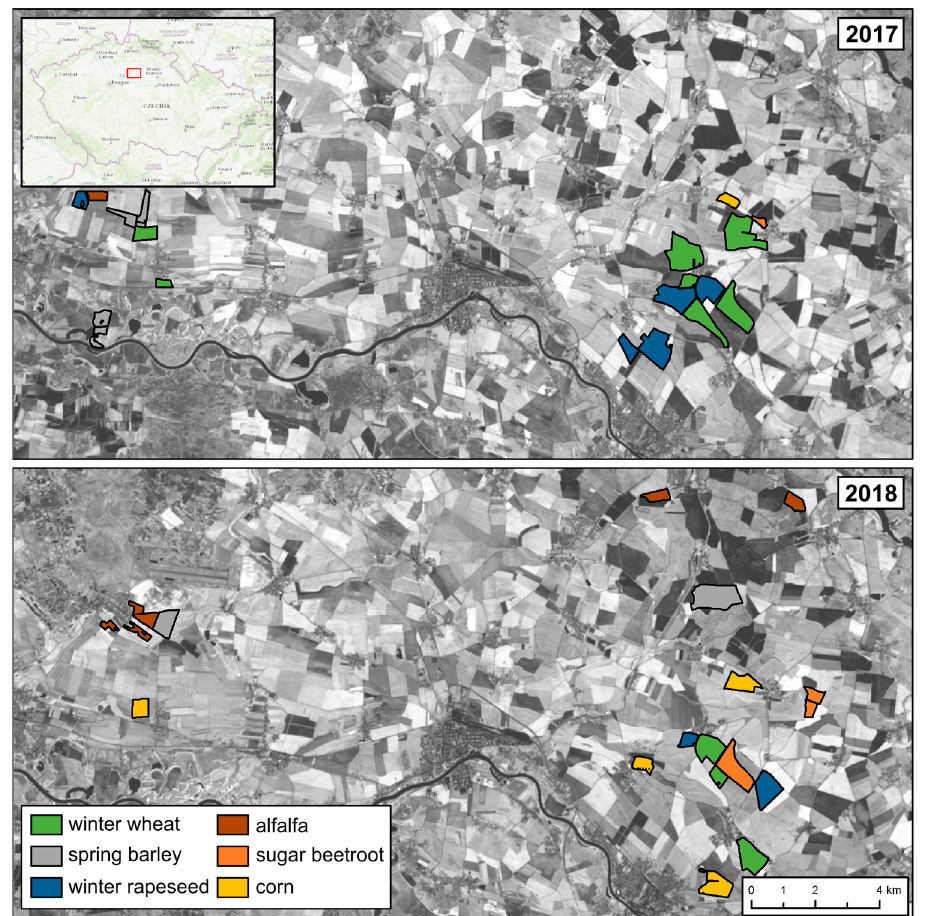
Figure 1. Location of agricultural plots where campaigns were conducted in 2017 and 2018, together with the grayscale near-infrared (NIR) band of the Sentinel-2 scene acquired in May of the respective year.